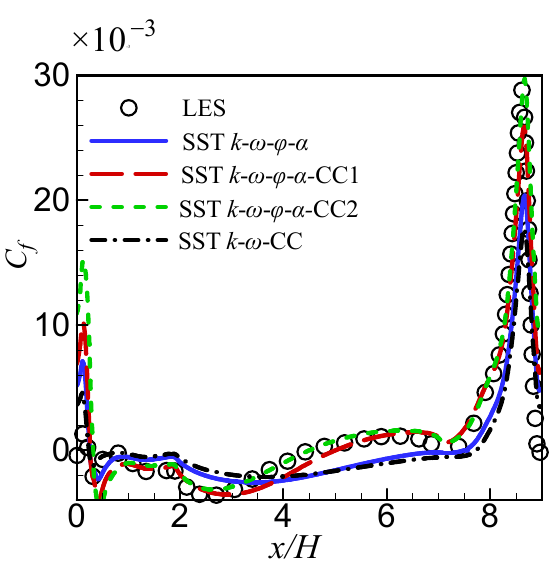
Figure 12. Comparison of velocity profiles at different transverse lines.